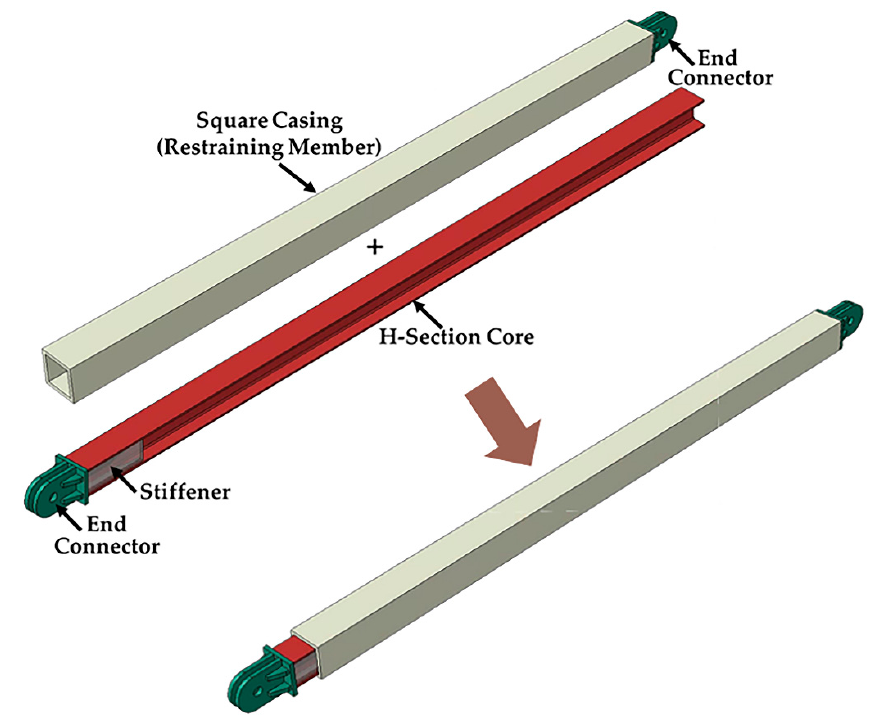
Figure 1. Noise, CO 2 emission, Vibration, Energy dissipation and Labor (NOVEL) buckling-restrained brace.